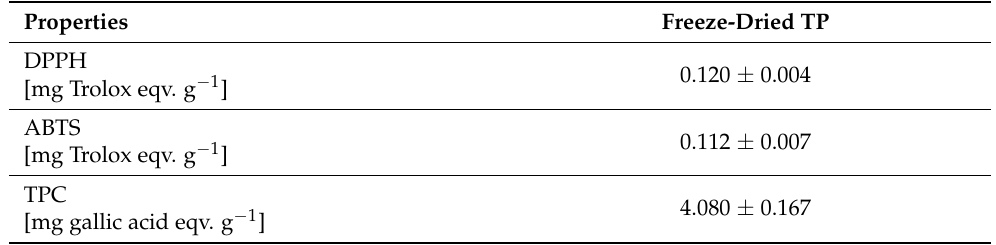
Table 1. Antioxidant activity and TPC of freeze-dried TP.